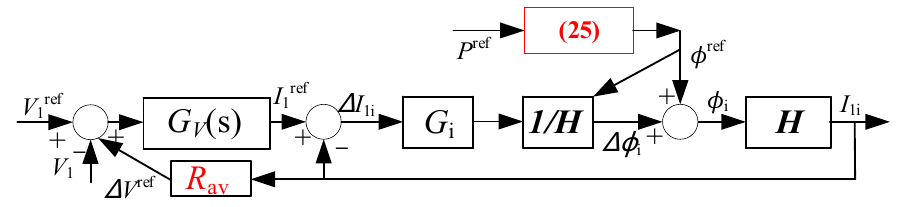
Figure 5. Control system block diagram of the DC/DC converter i.